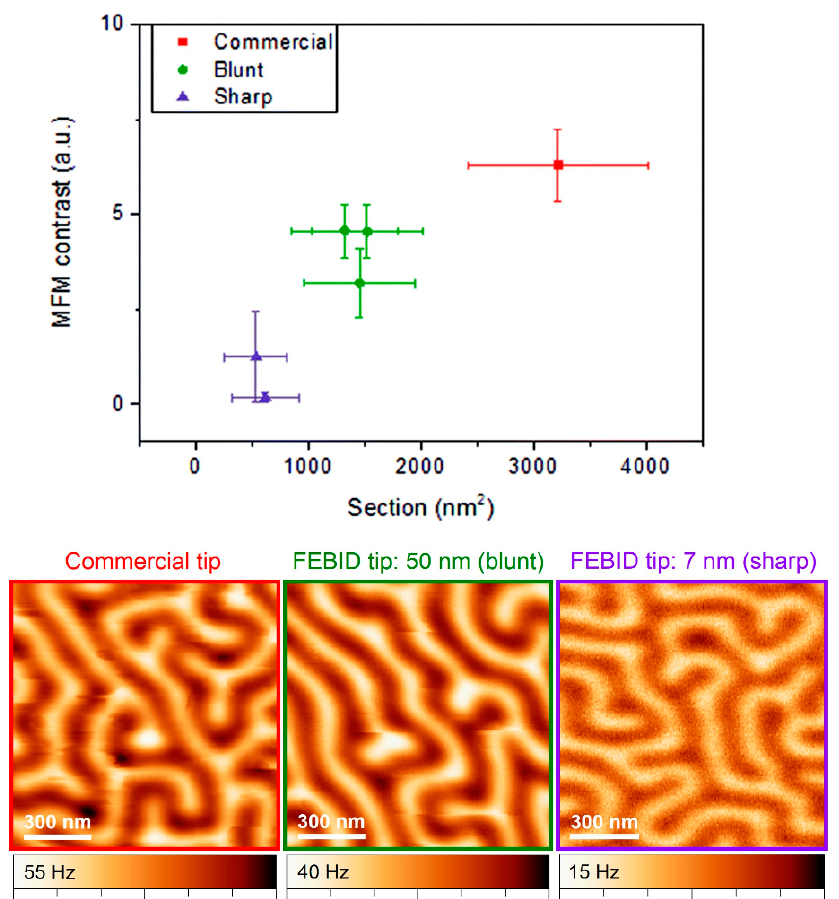
Figure 5. MFM contrast, related to the stray field values, as a function of the magnetic tip section, and their corresponding MFM images of a standard commercial MFM probe (red), a tip with an Fe-FEBID nanowire with a blunt tip end of 50 nm (green), and with a sharp end of 7 nm (purple). Adapted from [61] and reproduced from [41] with permission from the Royal Society of Chemistry.